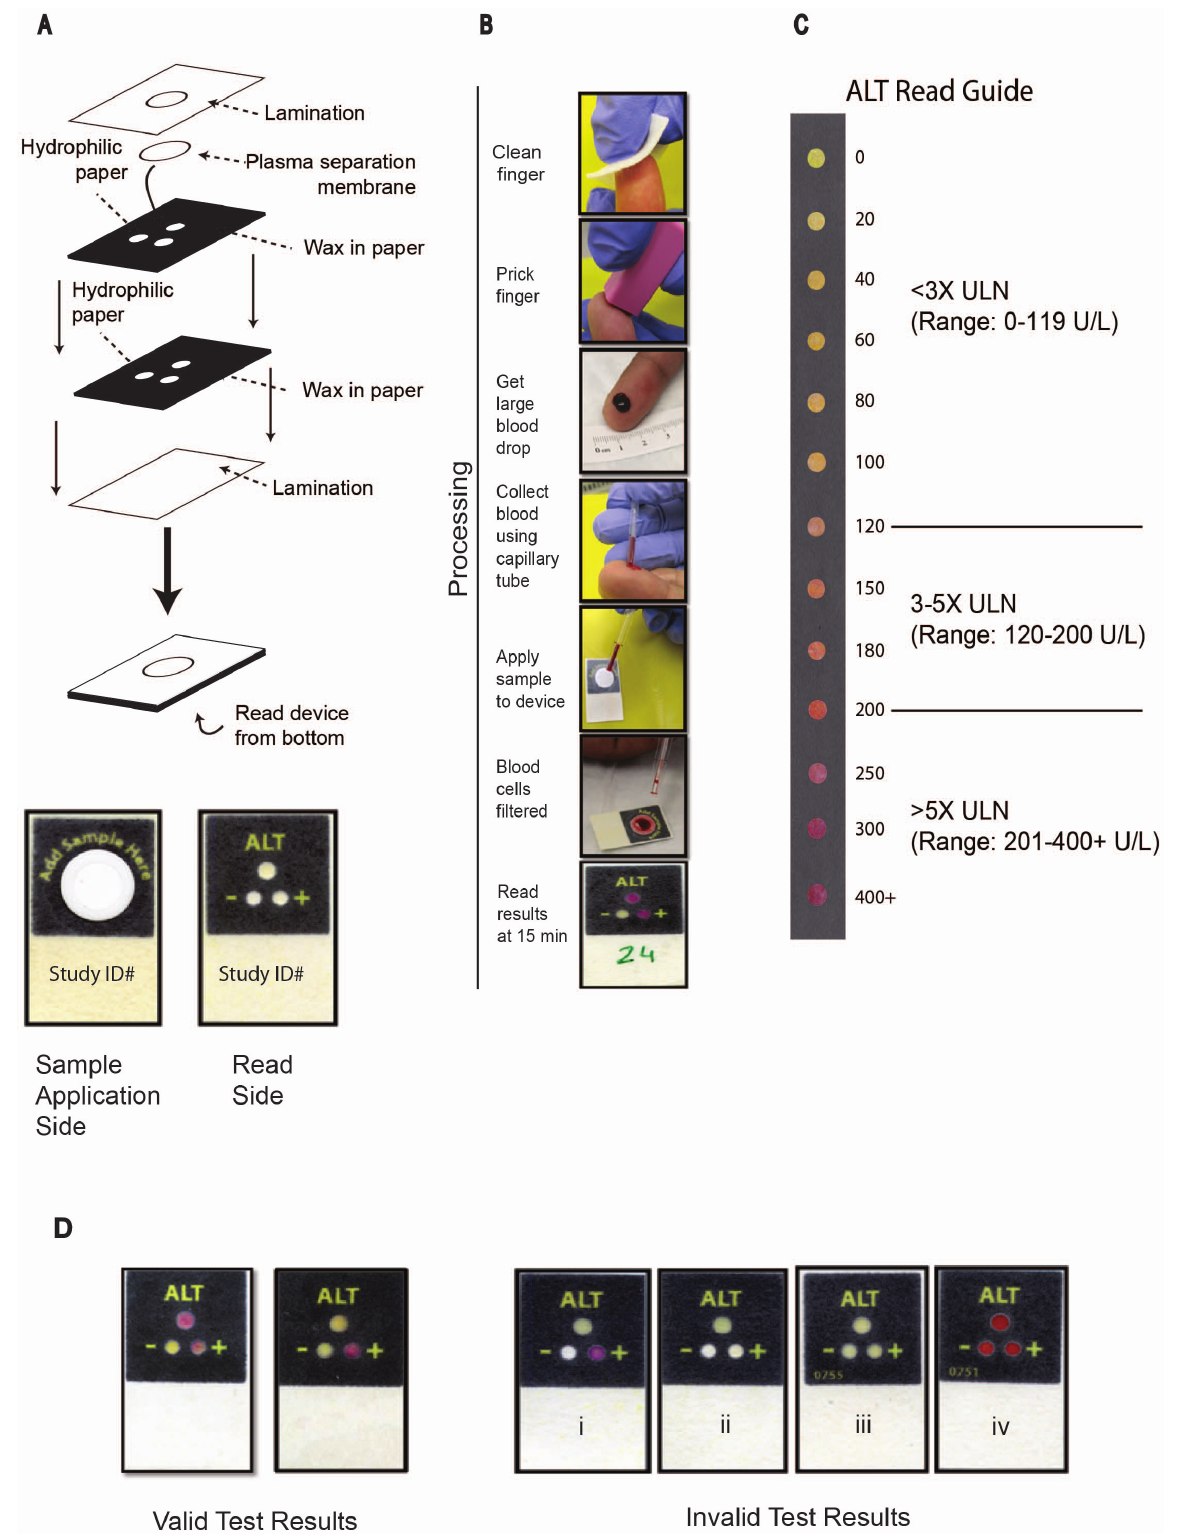
Figure 1. Schematic of 3-zone paper-based transaminase test design and performance. (A) The paper-based transaminase test is made from two layers of similarly patterned-paper, a plasma separation membrane (PSM), and lamination to protect the device from the environment. (A and B) A hole in the lamination allows for a fingerstick blood sample (collected using a capillary tube) to be applied to the PSM; blood cells are captured and retained by the PSM while plasma wicks into the individual ‘‘zones’’ in the first layer of paper below. In those zones, the plasma fluid reconstitutes dried reagents (as required for the zone-specific chemistry) and continues to wick to the second layer of paper, where analytes in the